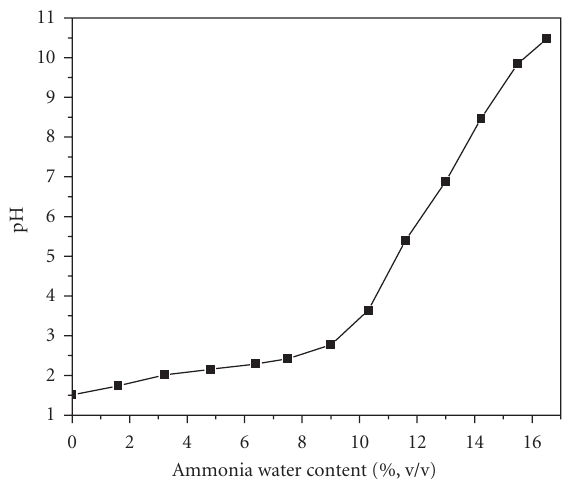
Figure 4: The electrical conductivity of PEDOT:PSS films as a function of doping ratio of AW.